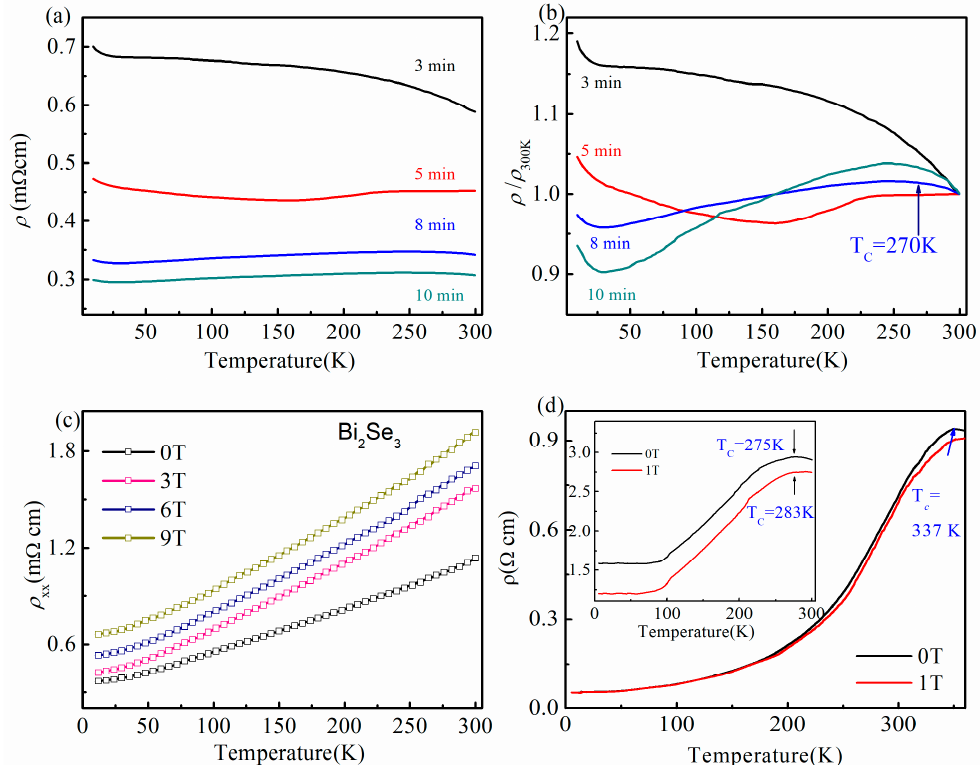
Figure 4. ( a ) Temperature dependence of resistivity of Bi 2 Se 3 /LSMO/LAO thin films deposited at different times at the zero field. ( b ) Resistivity normalization curve for Bi 2 Se 3 /LSMO/LAO thin films with different deposition times at th zero field. ( c ) Temperature-dependent resistivity for Bi 2 Se 3 /LAO thin films with different magnetic fields. ( d ) Temperature dependence of resistivity for LSMO/LAO thin films in 0 T and 1 T magnetic field. Inset: Temperature dependence of resistivity for polymer LSMO/Si films.